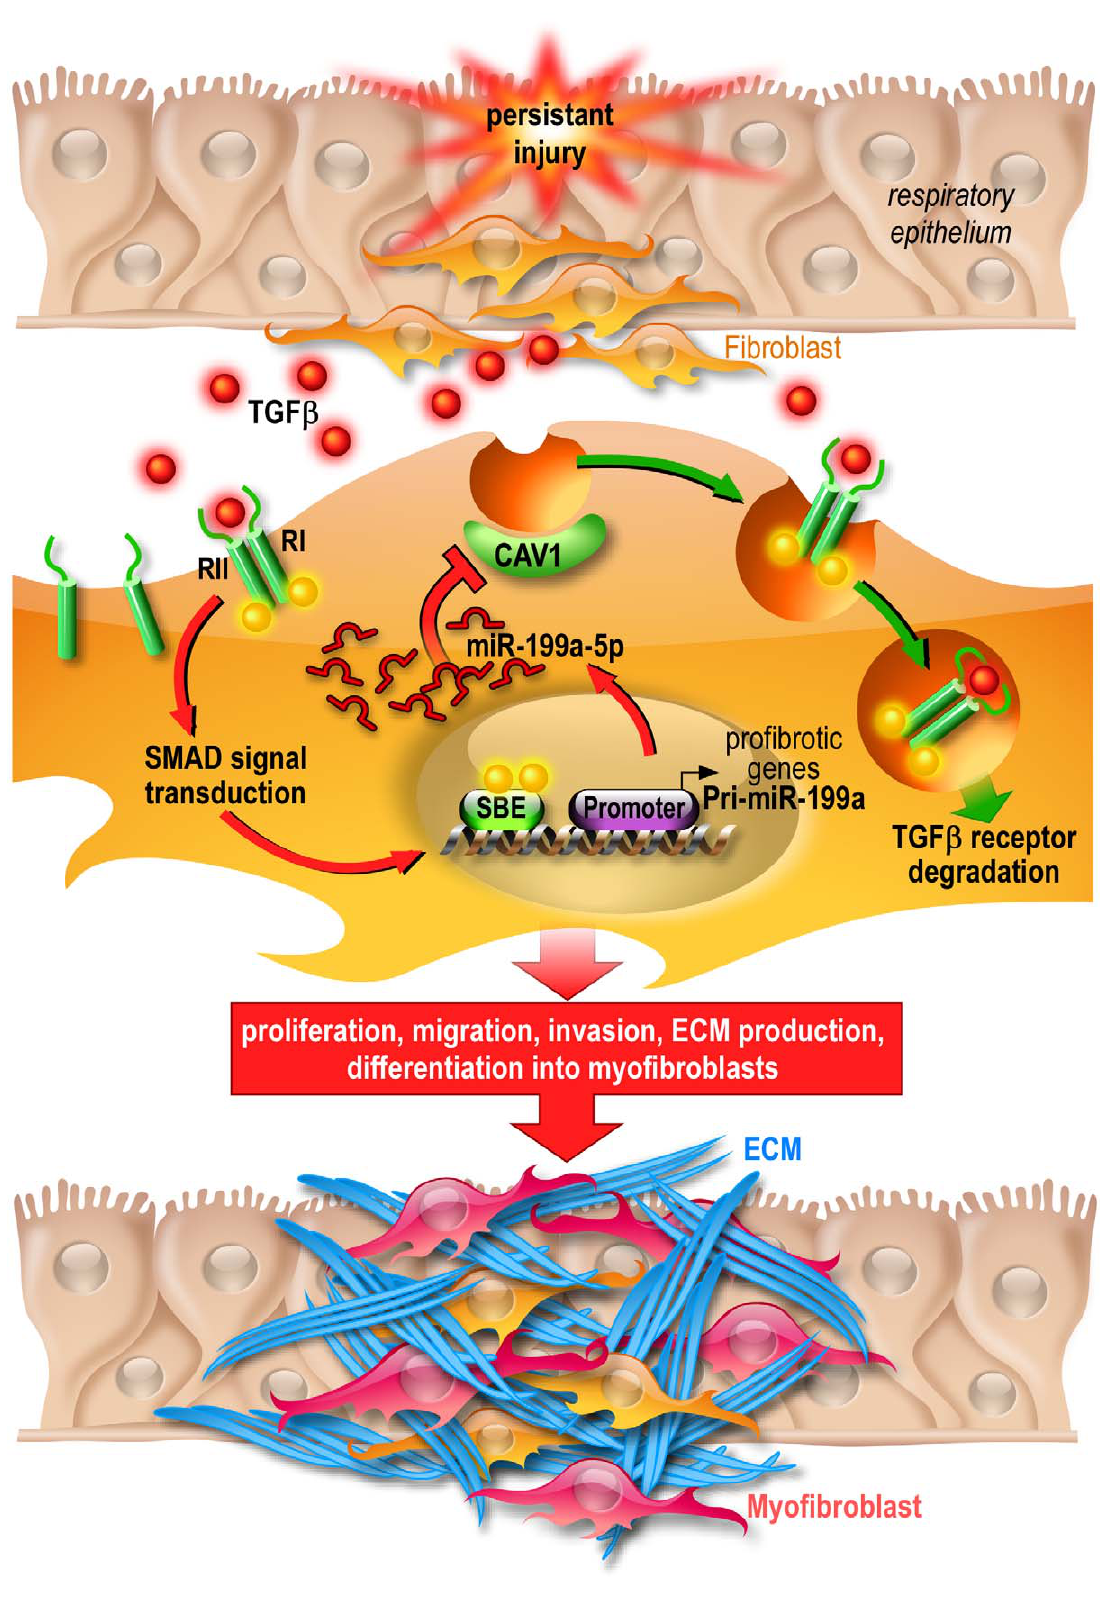
Figure 12. Proposed model of miR-199a-5p profibrotic function in lung fibrogenesis. Persistent injury of the respiratory epithelium causes release of profibrotic factors such as TGF b . In lung fibroblasts, TGF b binds to TGF b R I (RI) and II (RII) and the resultant complex can be internalized via two distinct endocytic pathways. The clathrin-coated pit pathway (red arrows) increases TGF b signal transduction leading to the activation of lung